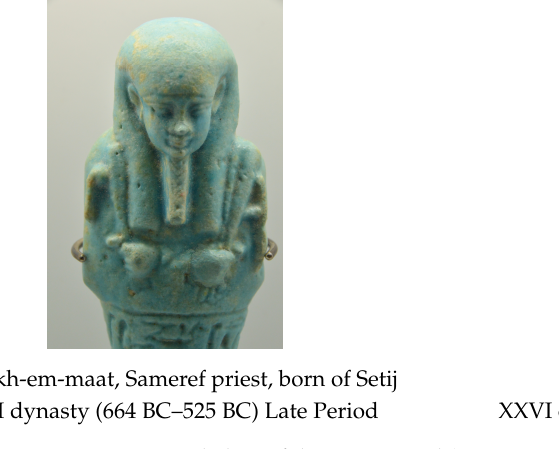
Figure 1. Shabtis of the Late Period (664 BC–332 BC). Private